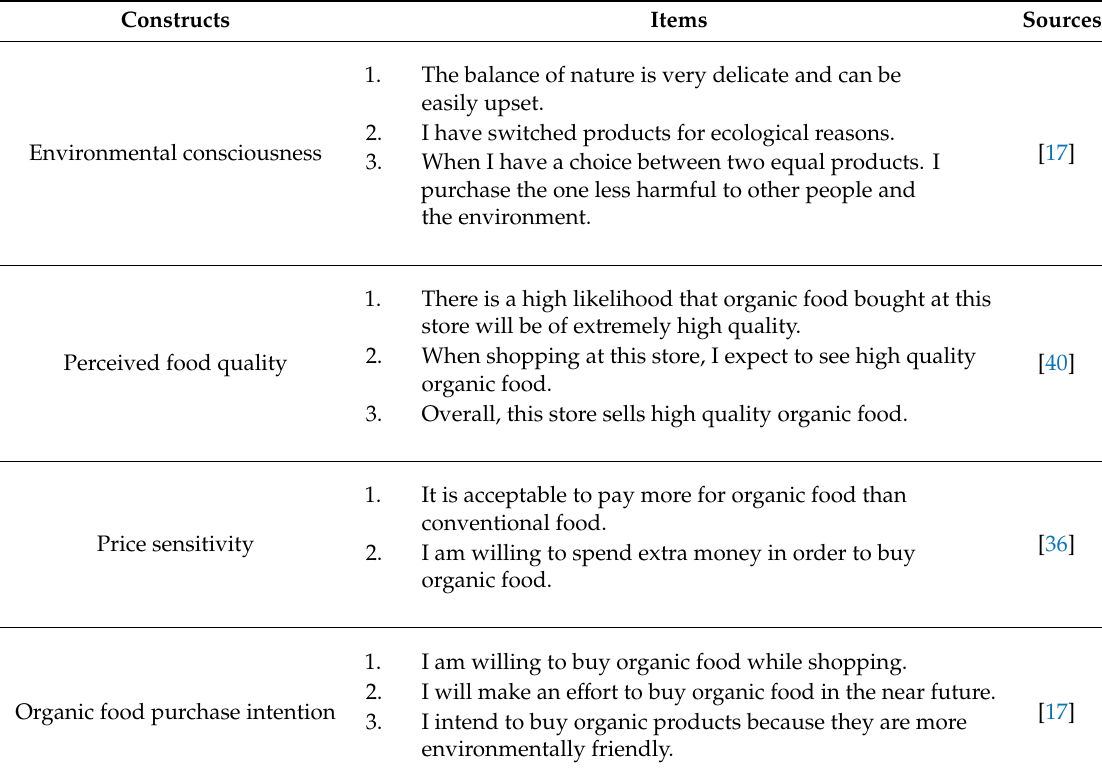
Table 2. Constructs and